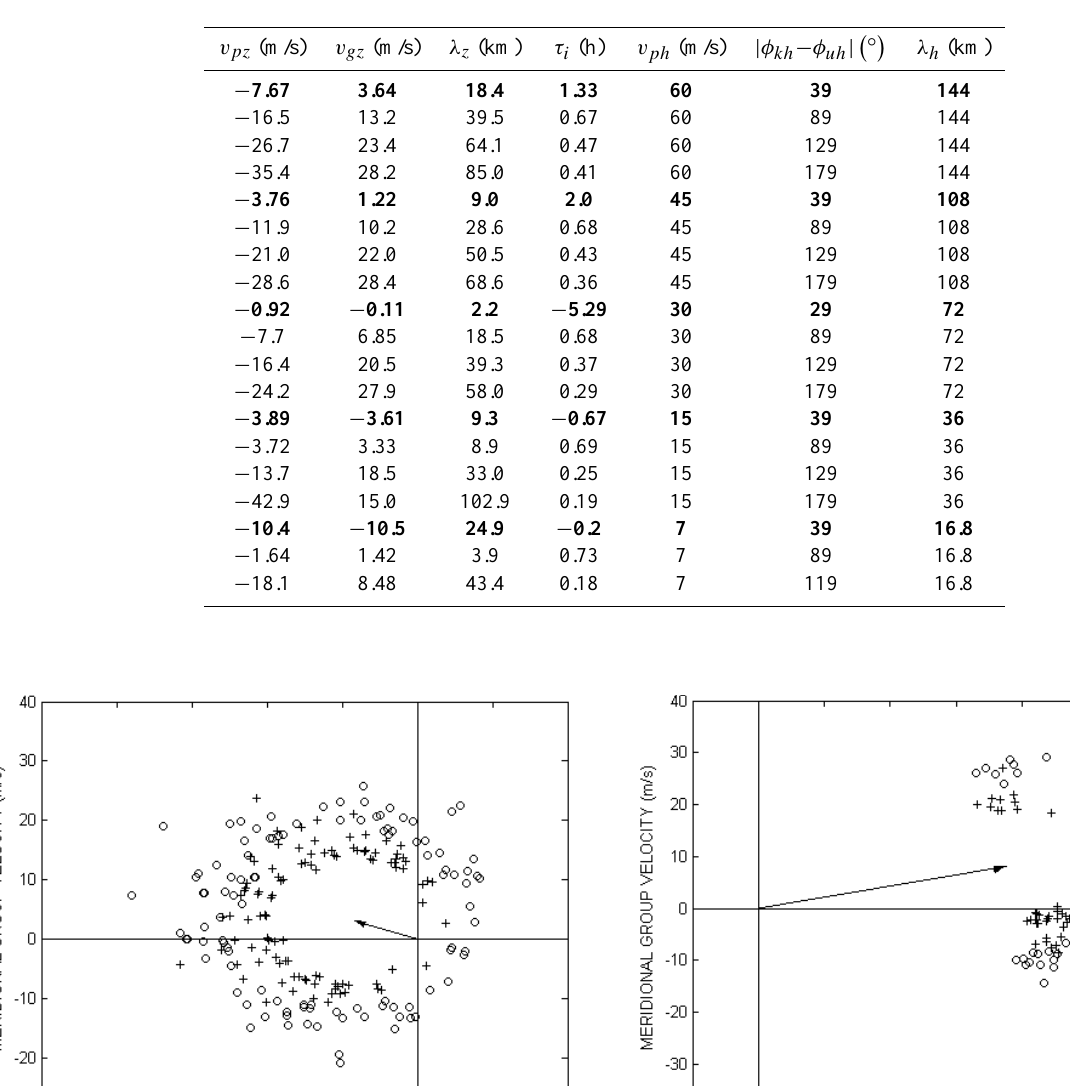
Table 5. Characteristic physical parameters ( v pz , v gz , λ z , τ i , v ph , φ kh , λ h ) of the AGW wave packets with a characteristic wave pe- riod of τ = 40min obtained by dispersion relation under the winter background wind with u E = 37 . 8m/s and u N = 8 . 1m/s ( u h = 38 . 7m/s, φ uh = 77 . 9 ◦ ) . φ kh and φ uh are the azimuth angles of the horizontal wave vector and mean wind velocity, respectively.